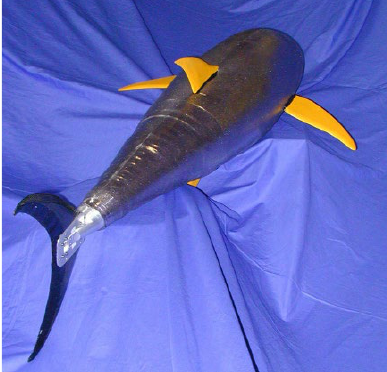
Figure 17. Fish-robot prototype [33].